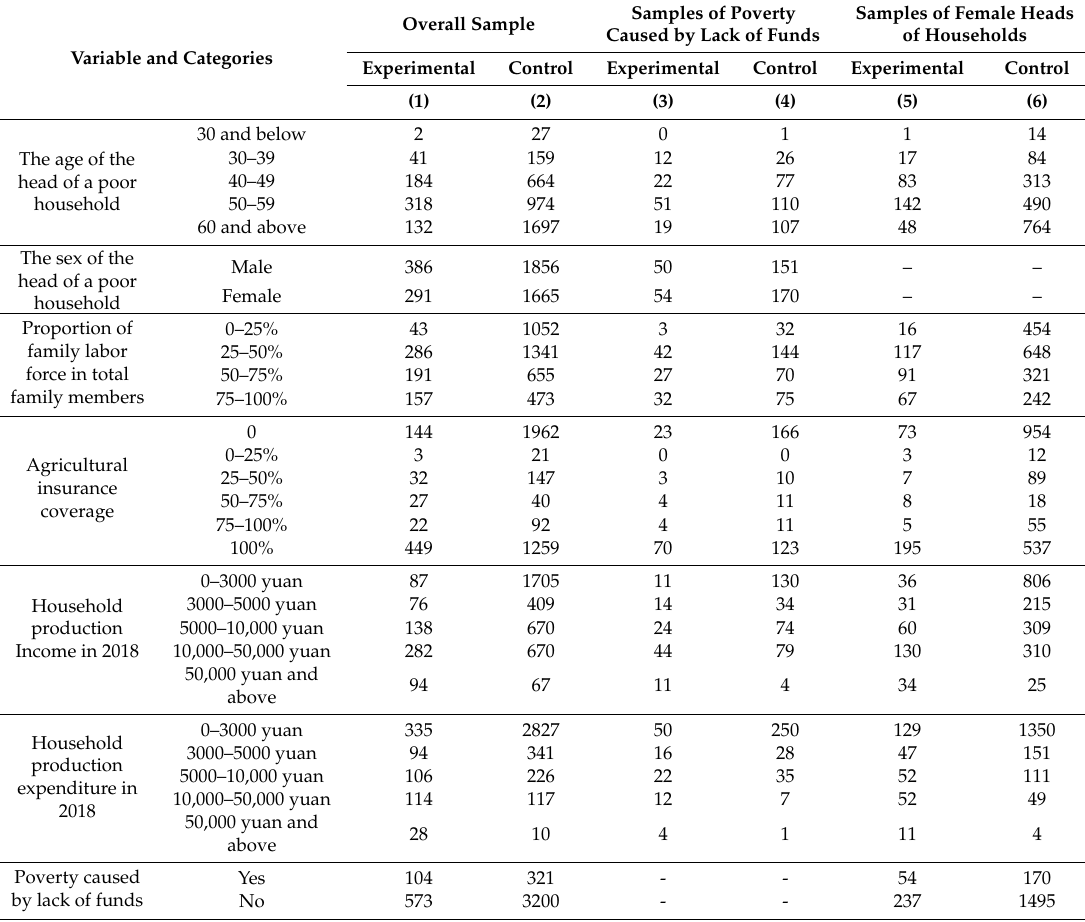
Table 1. Basic characteristics of the heads of poor households and their families.